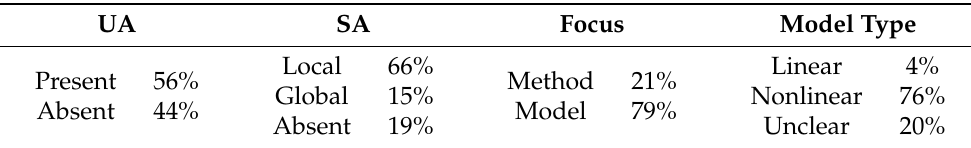
Table 3. Results of the bibliometric study according to the selected search